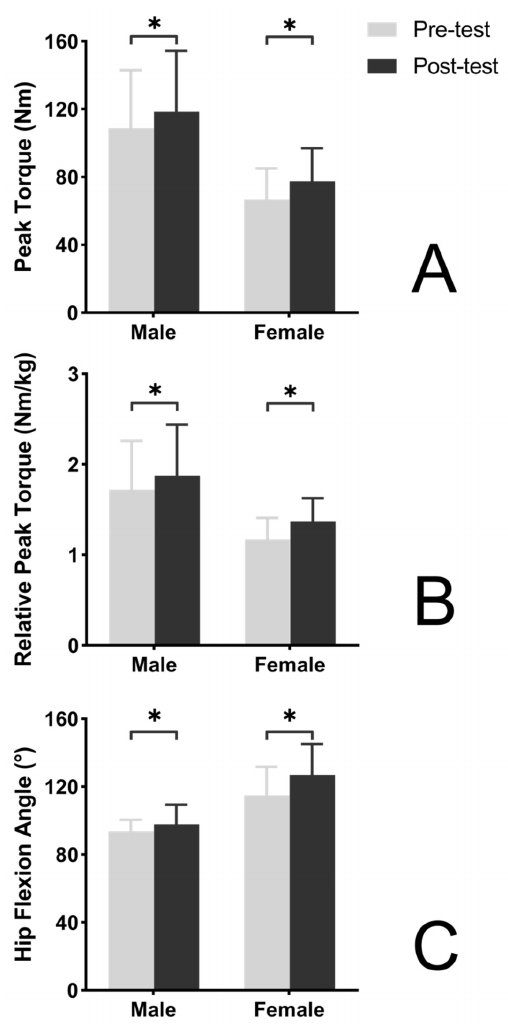
Figure 1. Effects of an 8-week strength training program on hamstring strength and flexibility. ( A ) Training effect on peak torque. ( B ) Training effect on relative peak torque. ( C ) Training effect on hip flexion angle. * Significant training effects.